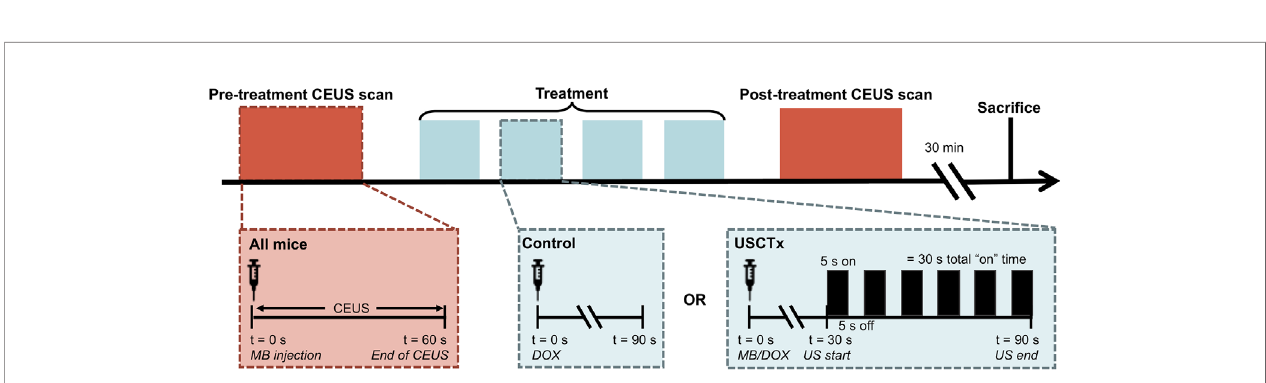
FIGURE 2 | Overview of experimental protocol. 60 s CEUS loops were taken before and after therapy on all mice, regardless of experimental group. Treatment is de fi ned by 4 injections of DOX alone (control) or DOX + USCTx. There were 90 s between each injection. The mice were sacri fi ced 30 min after the post-treatment CEUS